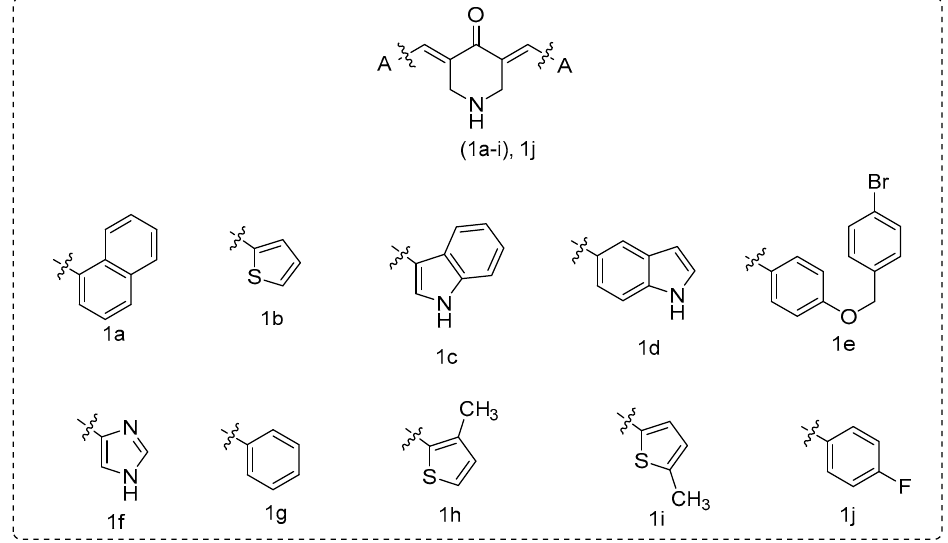
Figure 3. Curcumin analogues 1a – i were previously reported from our research group [40] and 1j [47,48].